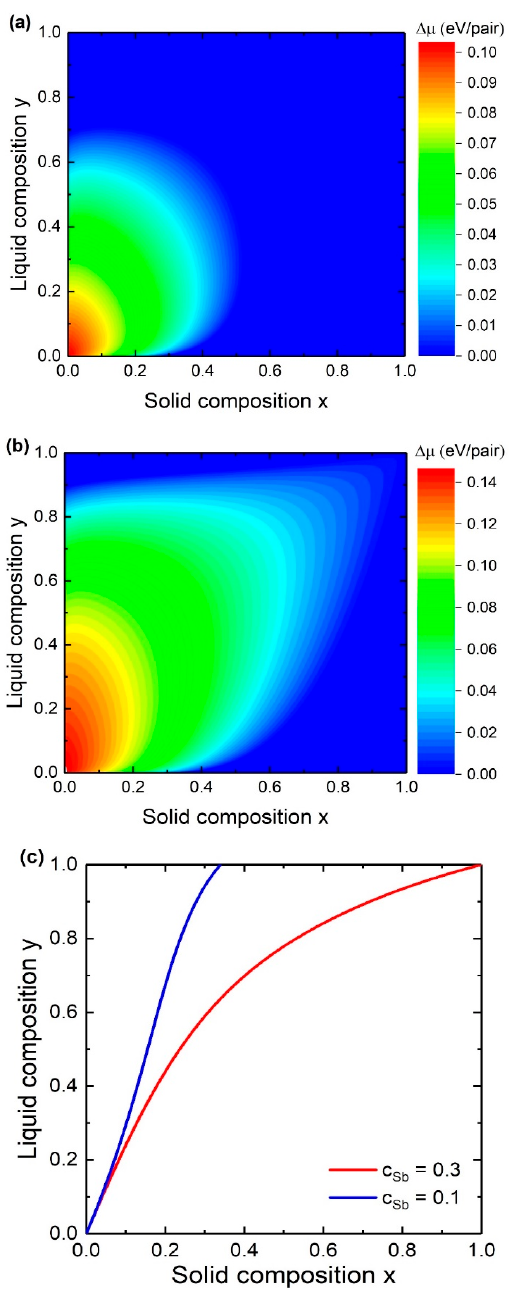
Figure 7. Chemical potential difference between the liquid and solid for different Sb concentrations in the liquid ( c Sb = 0.1 ( a ) and c Sb = 0.3 ( b )) and liquid-solid composition dependences of In x Ga 1 − x Sb NWs ( c ) at fixed Au concentration c Au = 0.2 and temperature T = 450 ◦ C. For better clarity, only the positive values of the chemical potential difference are presented. Negative values are shown as level 0 (dark blue).